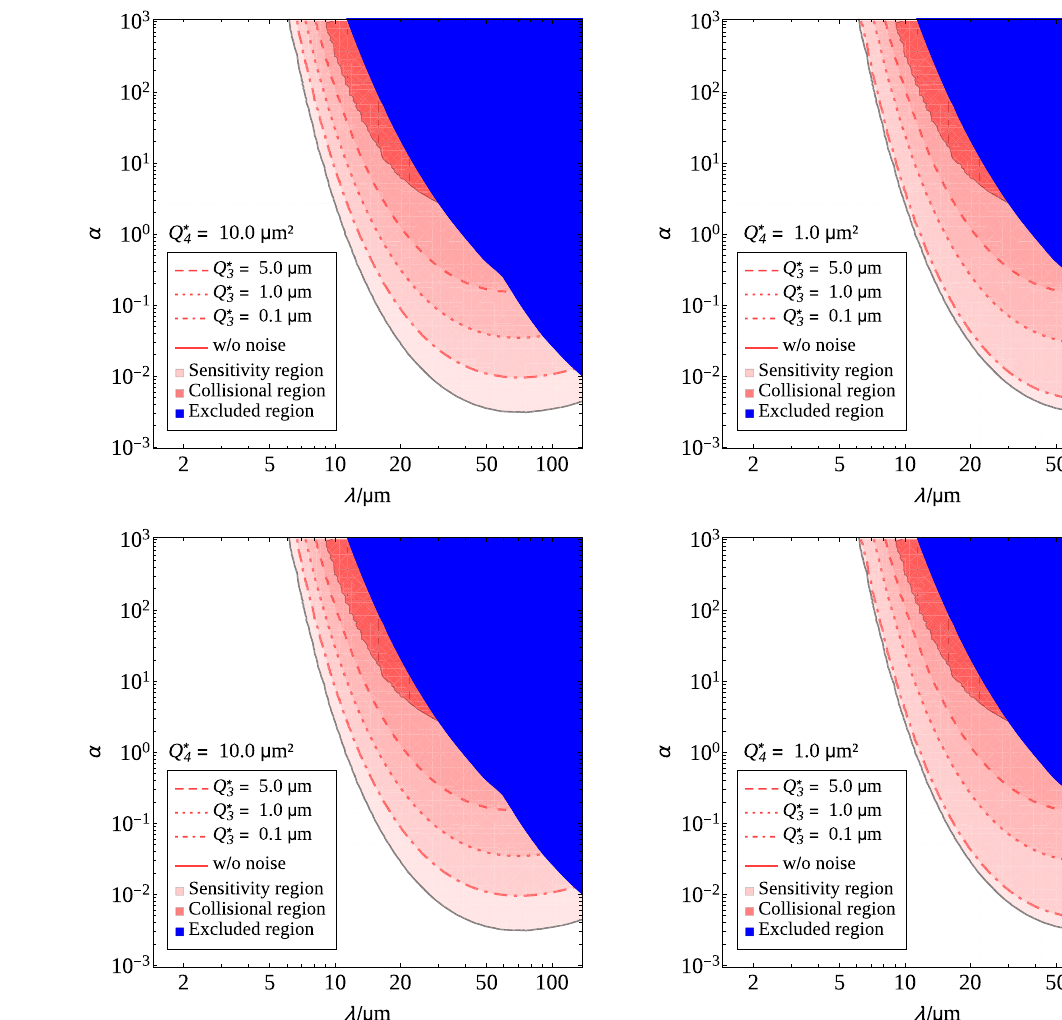
differencebetween (cid:11) T max and (cid:11) T max tobeequaltotwicetheexpected BN mN clockerror, σ T = 1s.Toprow: Case1 .Bothpanelsassume Q 2 = 10 − 3 and fixed Q 4 (left panel: Q 4 = 1 μ m 2 ; right panel: Q 4 = 0 . 1 μ m 2 ). In each panel, several values of Q 3 are shown: Q 3 = 0 . 05 μ m (dot- dashed line), Q 3 = 0 . 1 μ m (dotted line), and Q 3 = 0 . 5 μ m (dashed line), as reported in each plot legend. Bottom row: Case 2 . Both panels assume Q 2 = 10 − 2 and fixed Q 4 (left panel: Q 4 = 10 μ m 2 ; right panel: Q 4 = 1 . 0 μ m 2 ). In each panel, we have: Q 3 = 0 . 1 μ m (dot- dashed line), Q 3 = 1 . 0 μ m (dotted line), and Q 3 = 5 . 0 μ m (dashed line). In all cases the solid line corresponds to the noiseless scenario as presented in Fig.